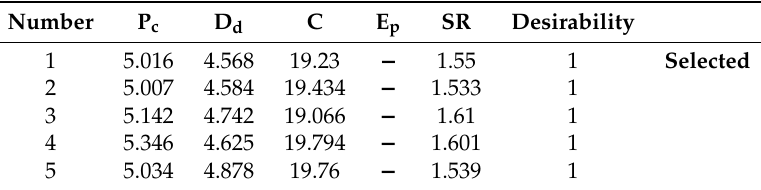
Table 8. Suggested solutions for minimizing SR.